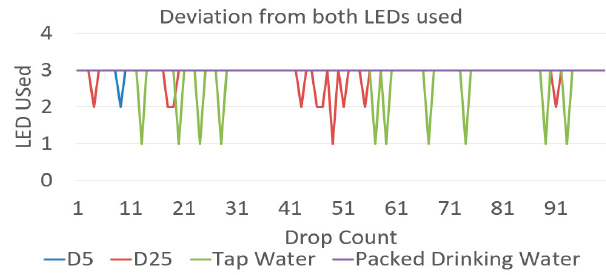
Figure 15. Graph between drop count and LED used for different fluid used.